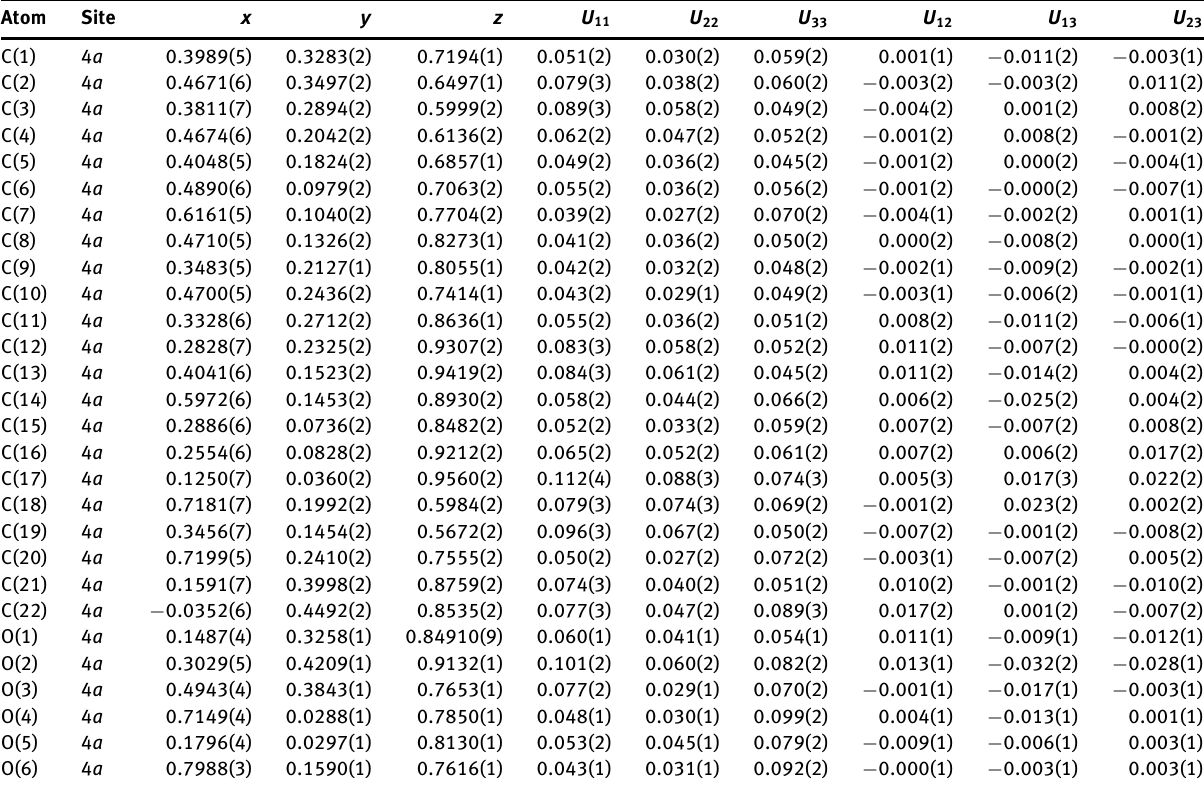
Table 3: Fractional coordinates and atomic displacement parameters (Å 2